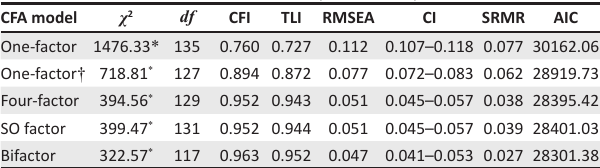
TABLE 1: Model fit indices for confirmatory factor analysis models tested.